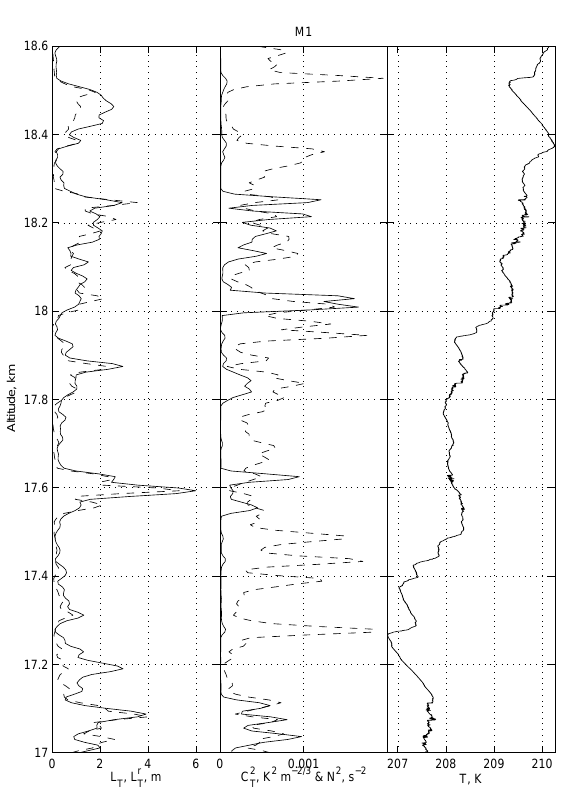
Figure 4. Same as Figure 3, but for flight M1 in the stratosphere Fig. 4. Same as Fig. 3, but for flight M1 in the